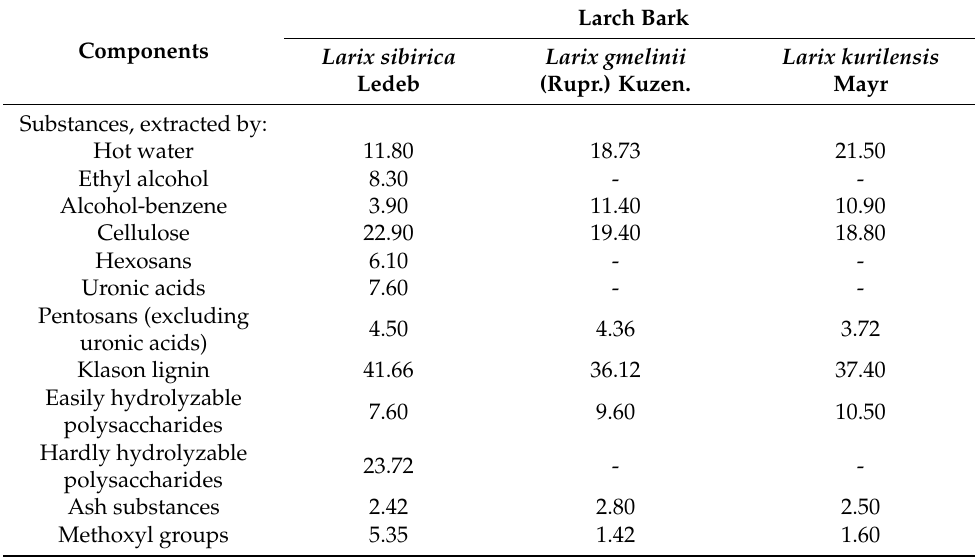
Table 2. Group composition of larch bark of various types, % a.d.m. [55].